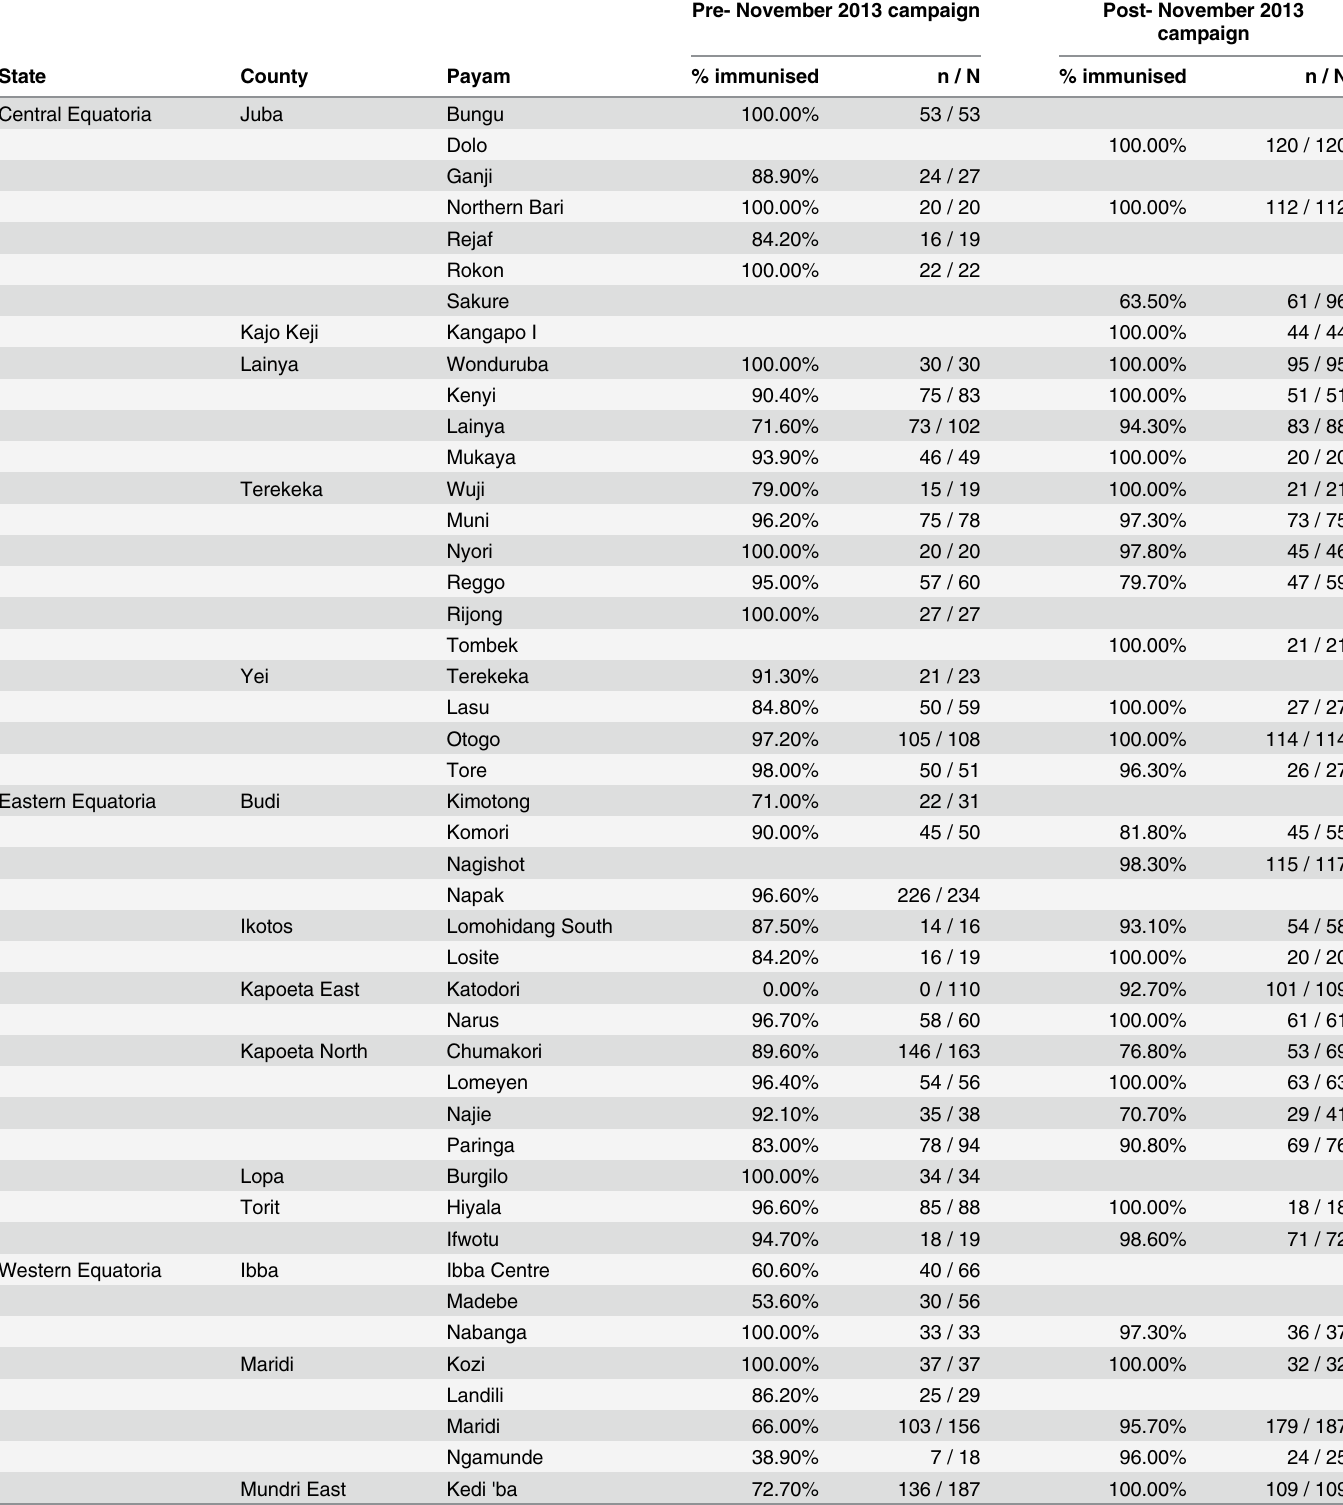
Table 1. Reported polio immunisation coverage (n / N) according to state, county and payam (pre- and post- November 2013 polio